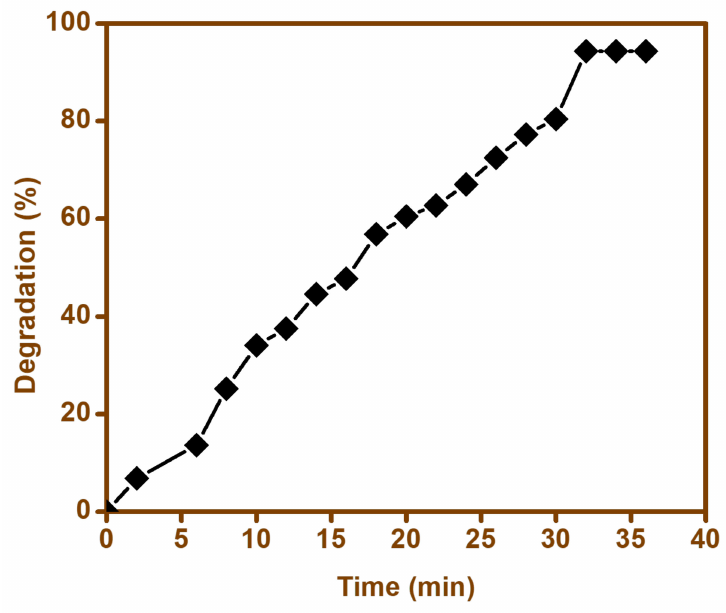
Figure 12. Time dependence of the degradation of cefixime trihydrate using BFO nanoparticles.